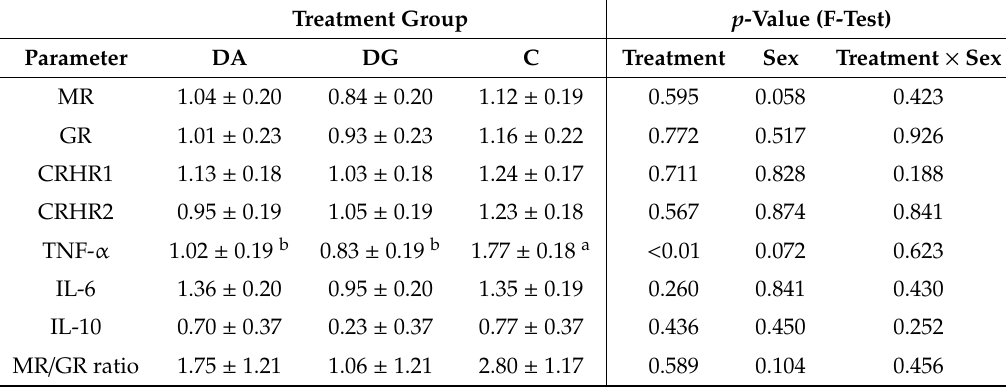
Table 3. Relative mRNA expression of HPA-related parameters and cytokines in the hypothalamus of piglets of the di ff erent treatment groups.